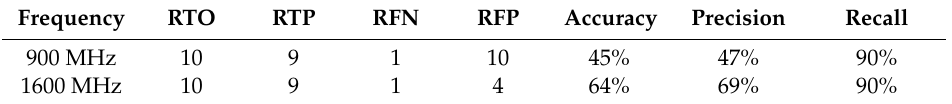
Figure 9. Three-dimensional (3D) root morphology maps generated by: ( a ) 900 MHz; and, ( b ) 1600 MHz GPR (experiment VIII). The black line represents the start / end line; the brown labeled lines represent the actual roots and their number; the brown non-labeled lines represent the fault roots created by the software; and, the green dash line represents the missed root (Root #2). Table 9. Accuracy, precision, and recall of the generated 3D maps for experiment IX.